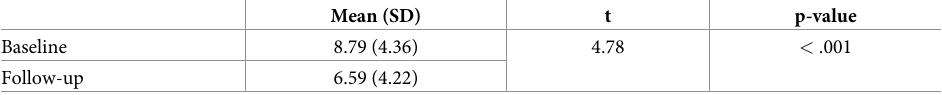
Table 3. Comparison of PHQ9 scores among patients with a baseline and follow-up assessment (n = 127).